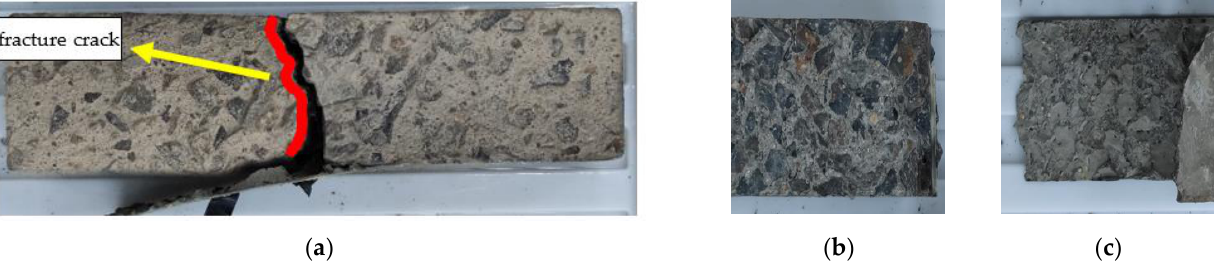
Figure 26. Failure mode of RFSF-100: ( a ) side surface; ( b ) concrete bonding surface; and ( c ) CFRP bonding surface.